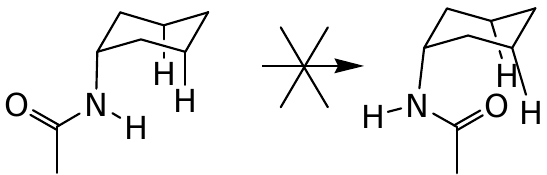
Figure 3. Restricted rotation about axial C-N bonds in cholapod